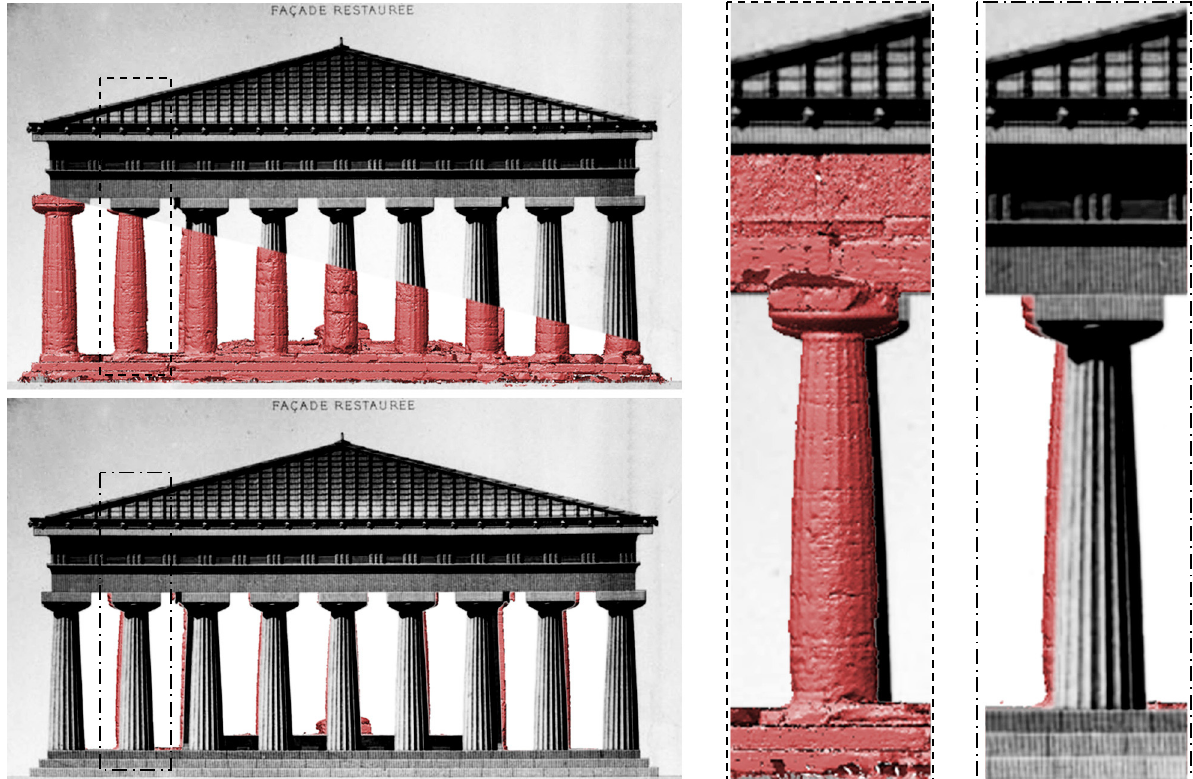
Figure 5: Facade of the “Basilica” (and two closer views): the laser scanning survey (in pink) overlapped on a historical drawing and reconstruction (Labrouste, 1877). Very few discrepancies are